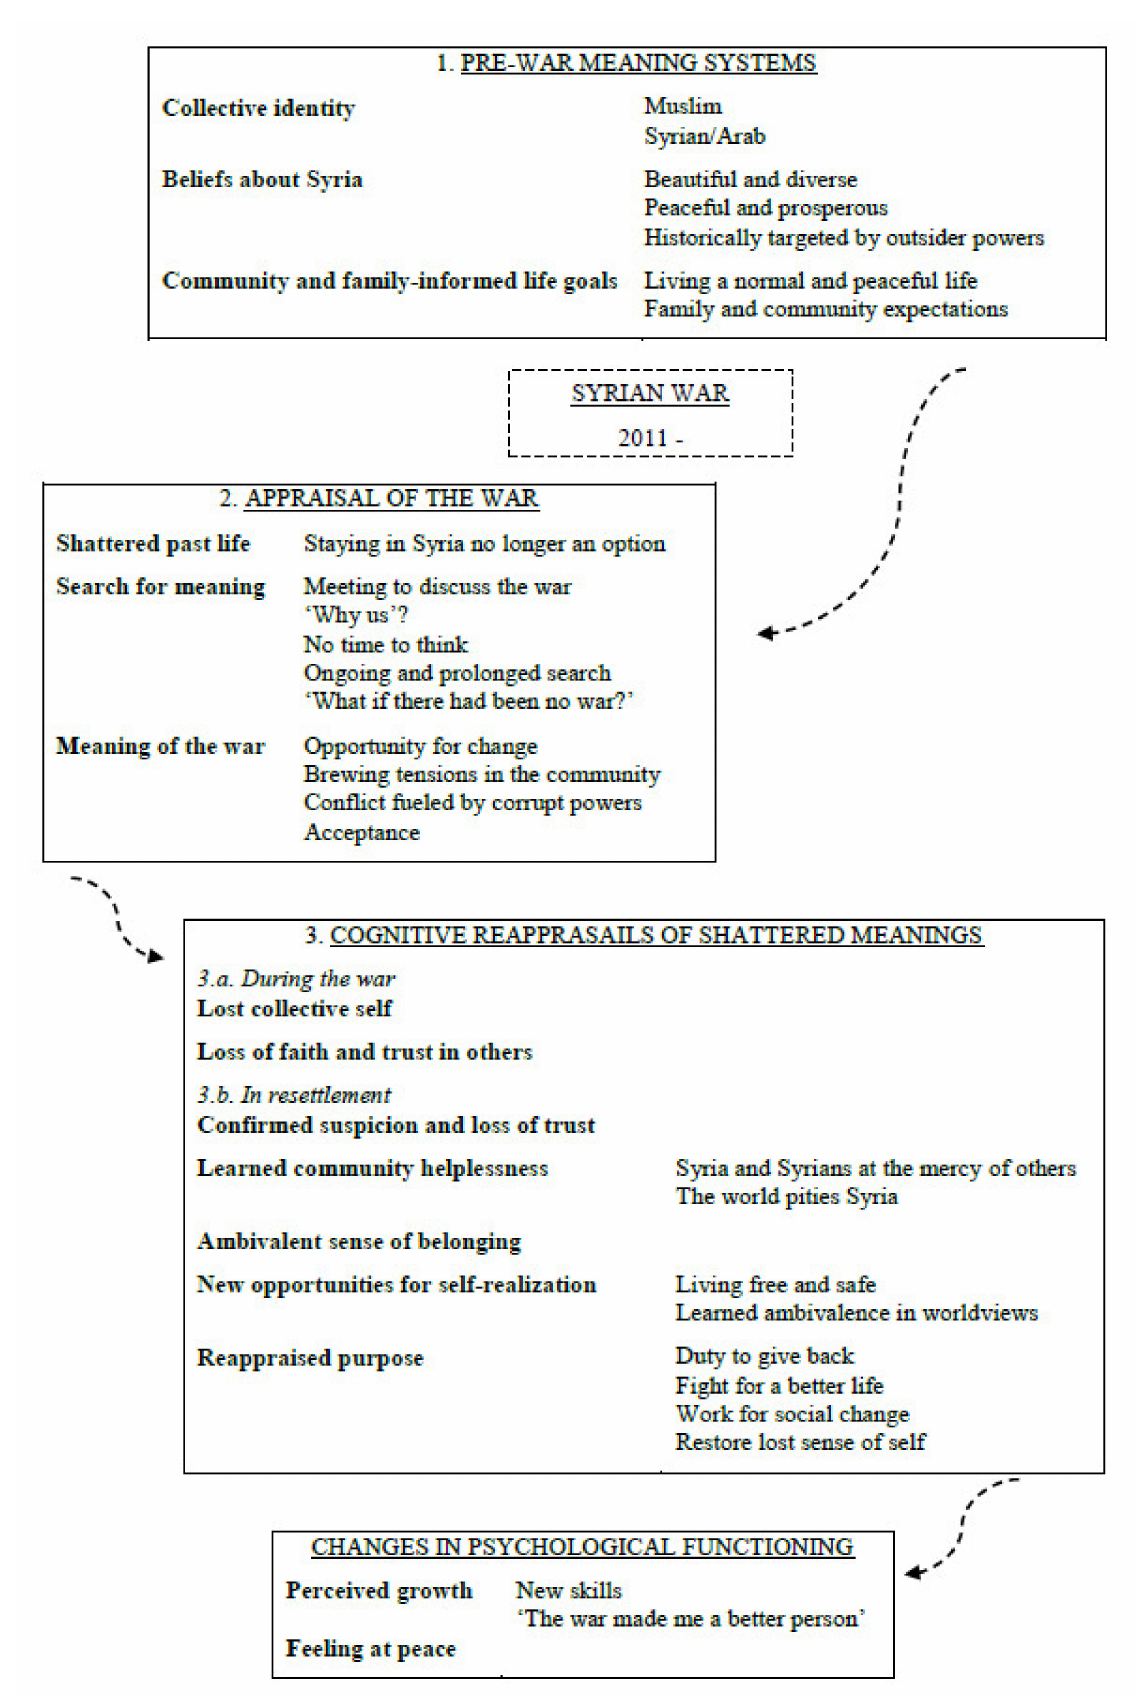
Figure 1. Thematic